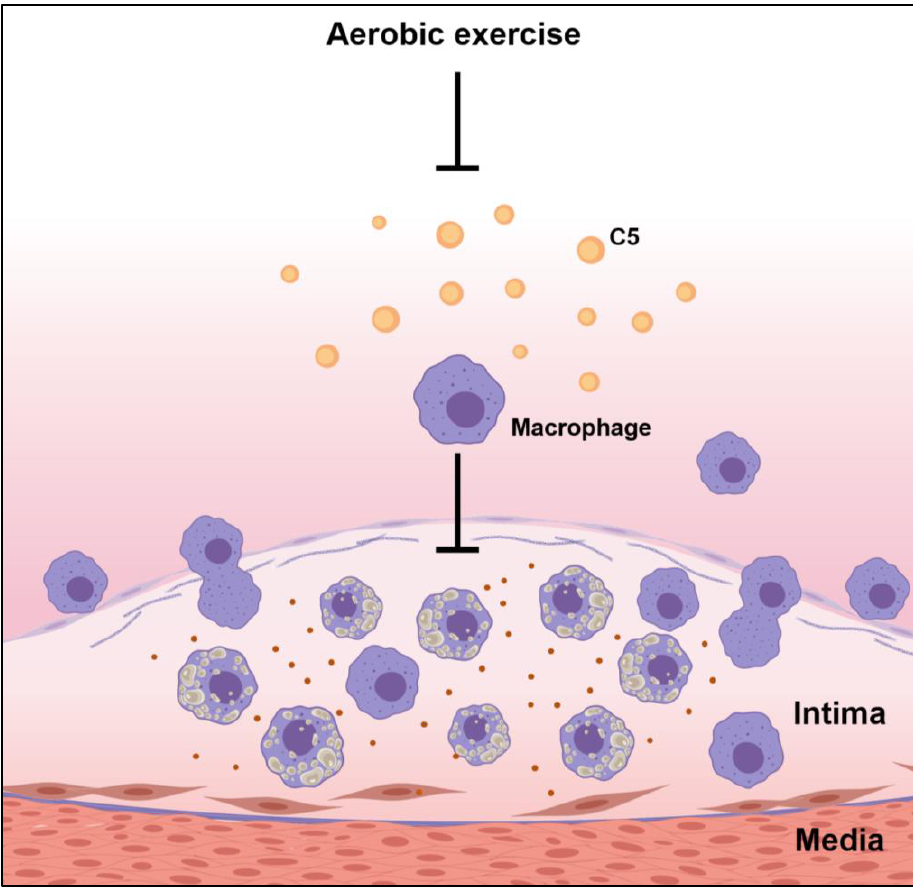
Figure 6. Possible effects of exercise on the pathogenesis of atherosclerosis.